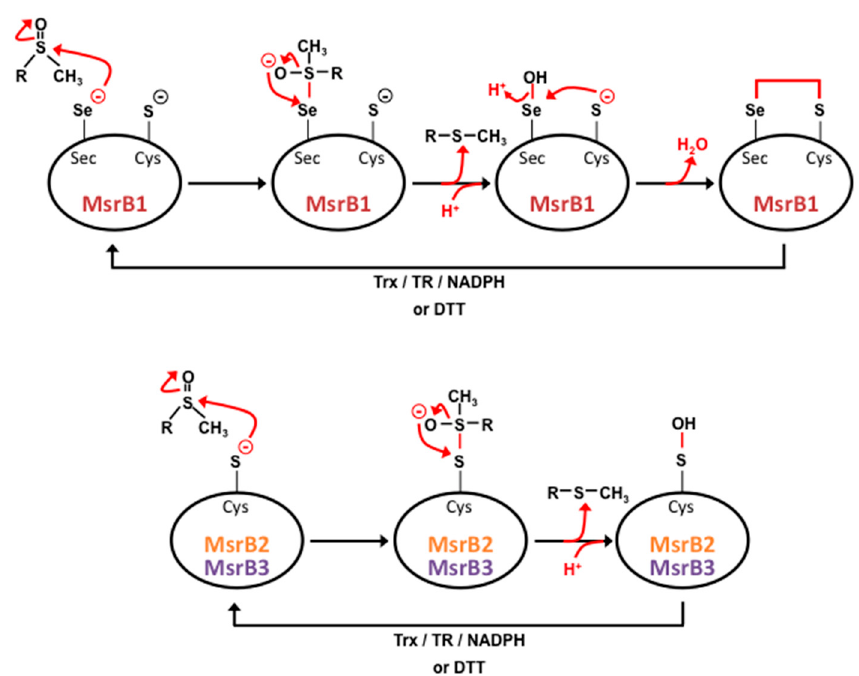
Figure 5. MsrB catalytic mechanism. In the case of MsrB1 (upper part of the figure), methionine sulfoxide reduction starts with the nucleophilic attack of selenocystein (Sec) on the sulfur atom of the substrate leading to the formation of an unstable intermediate. Ionic rearrangement leads to the formation of a selenic acid intermediate with the concomitant release of a methionine molecule. The nucleophilic attack of the recycling cysteine (Cys) on this selenic acid intermediate leads to the formation of an intramolecular selenenylsulfide bond, which is subsequently reduced by the thioredoxin (Trx)/thioredoxin reductase (TR)/NADPH regenerating system or by dithiothreitol (DTT). In contrast, the sulfenic intermediate of MsrB2 and MsrB3 (lower part of the figure), formed on Cys after methionine release, can be directly reduced to its fully active state by one of these mechanisms [68,70].